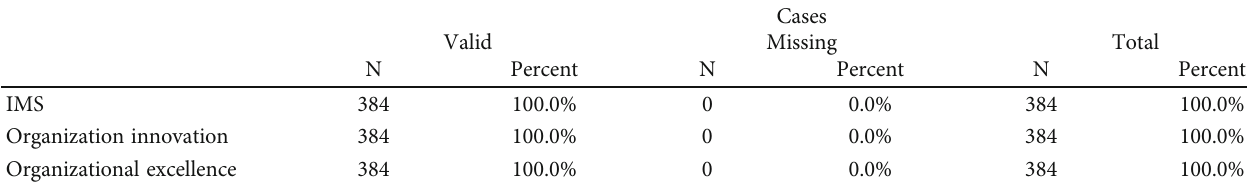
Table 3: Percentages and number of missing